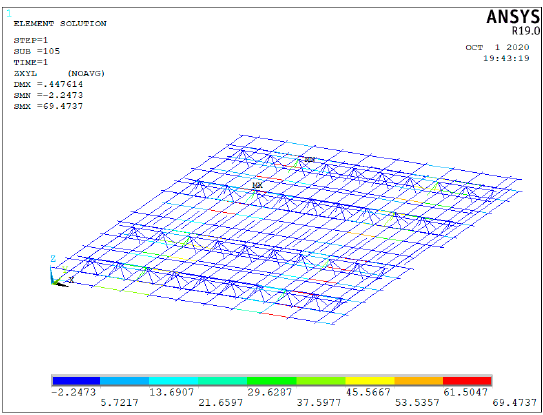
Figure 30. Stress cloud diagram of steel bar grid under ultimate load.